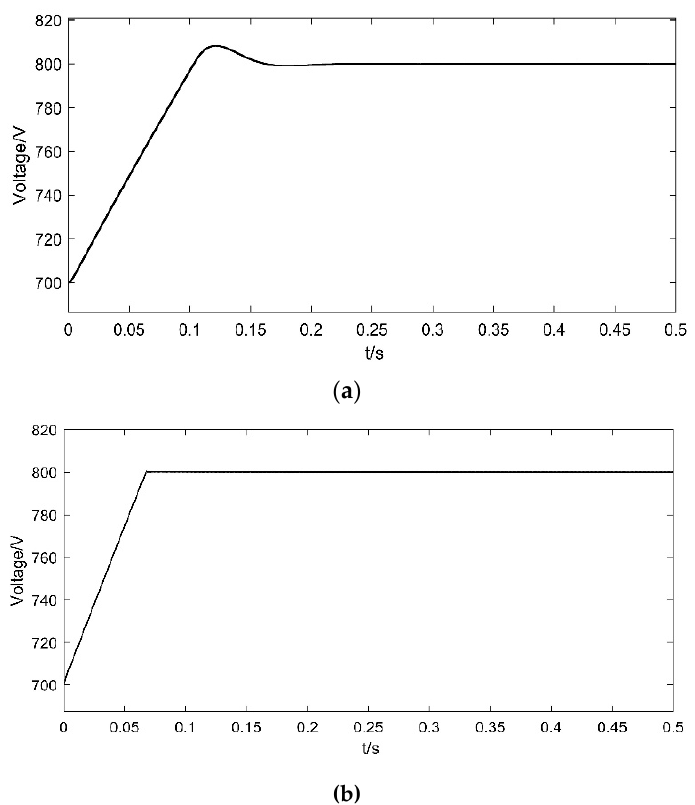
Figure 11. DC side voltage curve when using di ff erent controllers. ( a ) DC side voltage curve when using traditional LADRC, ( b ) DC side voltage curve when using improved LADRC. Amplitude phase diagram of improved LADRC and traditional